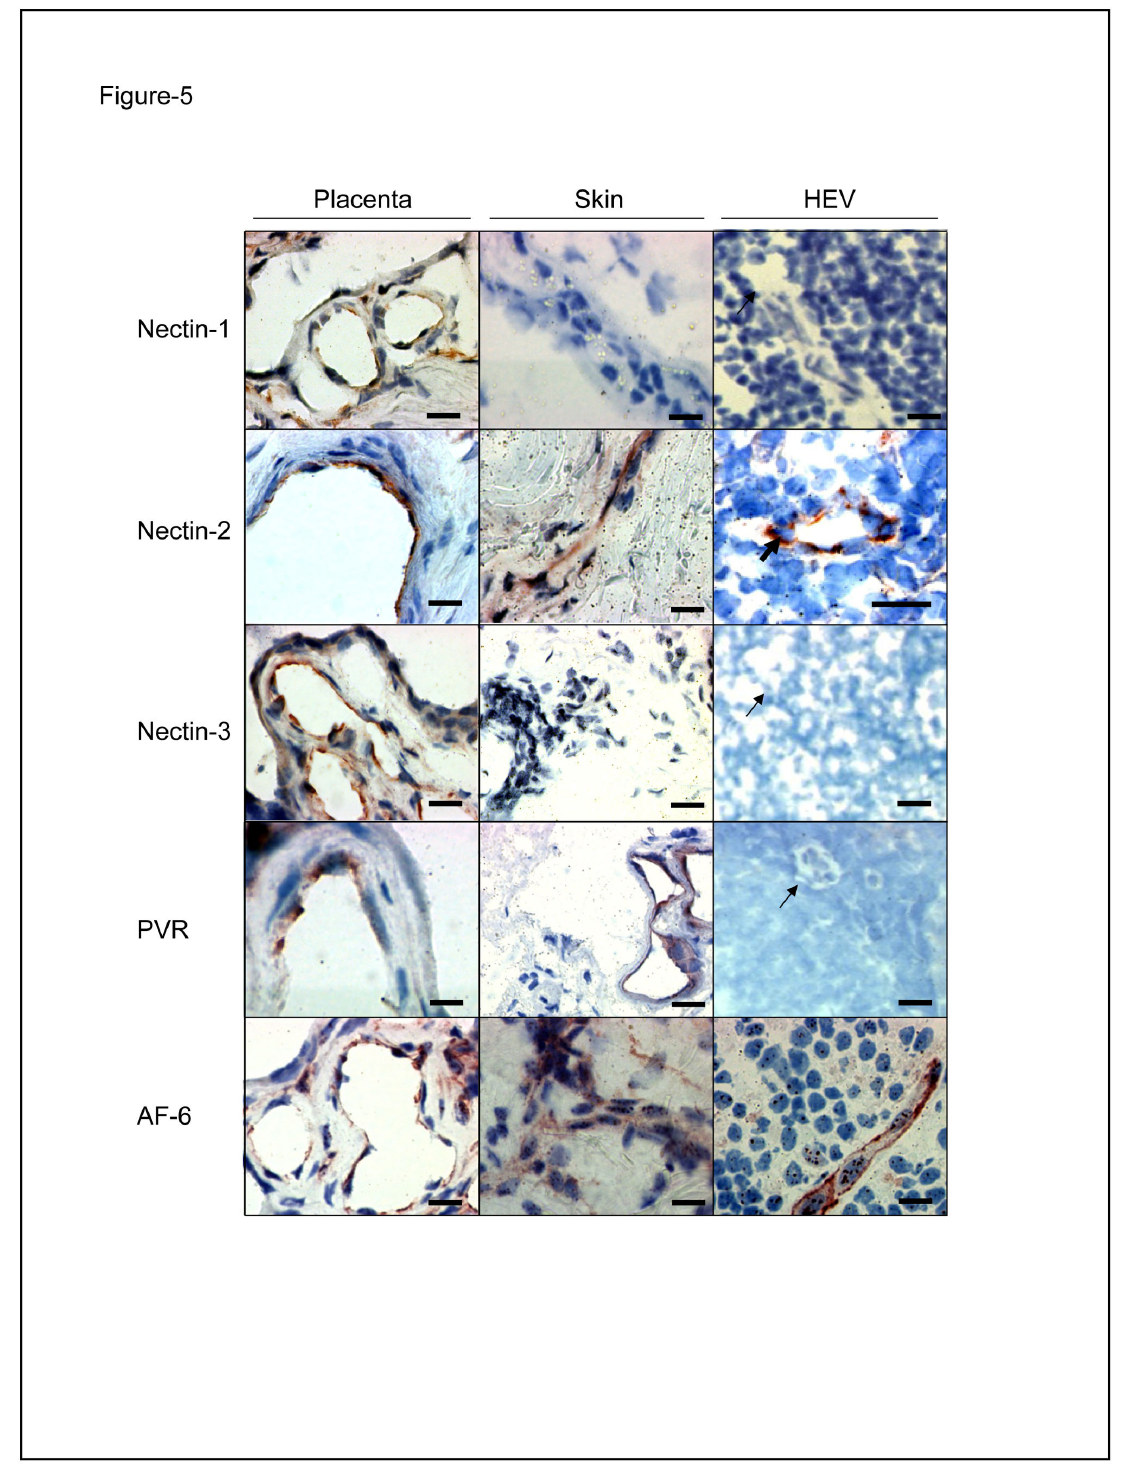
Figure 5. Nectin-2 is expressed on HEVs. Frozen sections of human placenta, skin and lymph nodes were analysed by immunohistochemistry with anti-Nectin-1 (R1.302), anti-Nectin-2 (R2.477), anti-Nectin-3 (N3.12), anti-PVR (PV.404) or anti-AF-6 mAbs. Representative images are shown. Bold arrows show positive specific HEV staining and arrows show negative HEV staining. Bars, 20 µm. doi: 10.1371/journal.pone.0077424.g005 PLOS ONE |